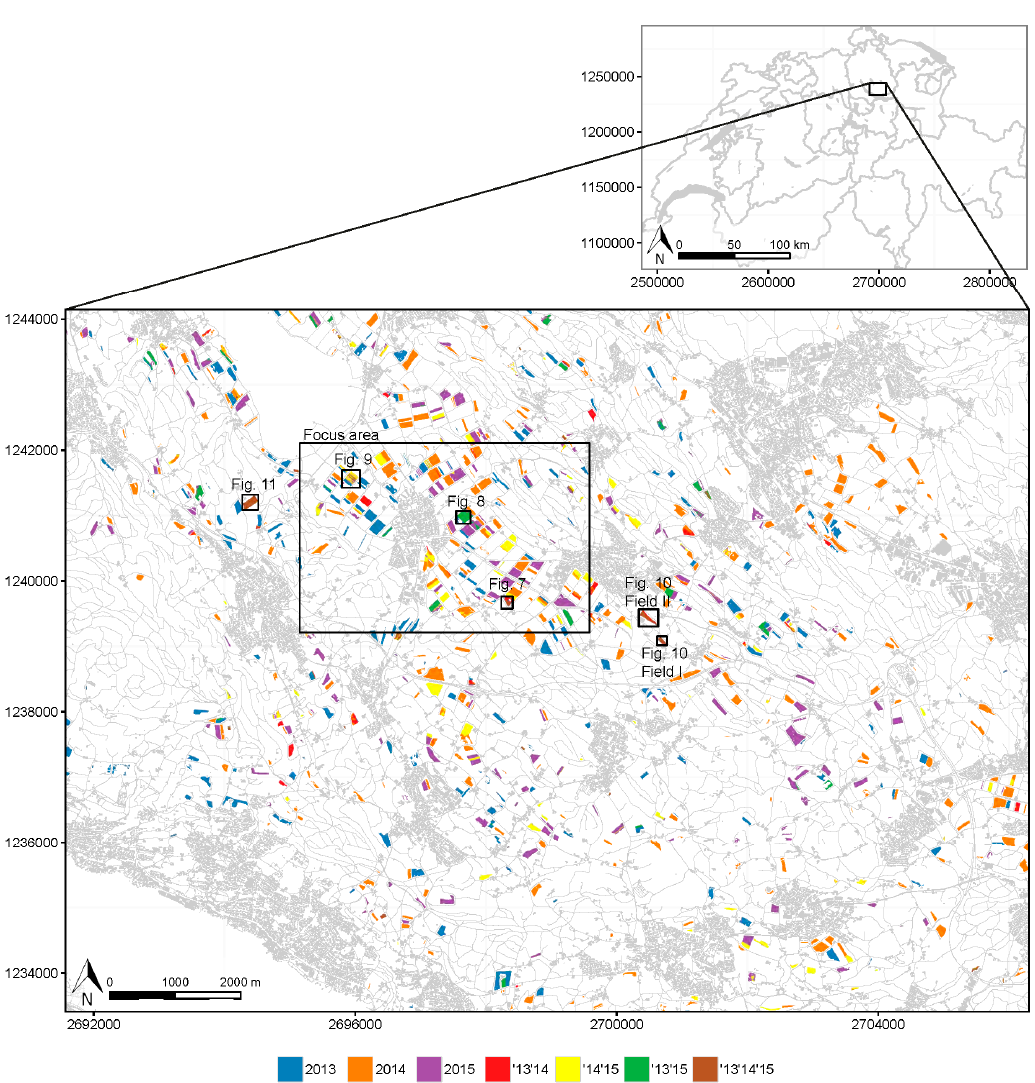
Figure 1. Study area and the distribution of the bare soil pixels, the colors show in which year(s) the considering bare soil pixel was present. The black rectangles show the locations of the focus area (used in most of the following figures) and the locations of the individual fields in Figures 7–10. The area contains a valley with a small glacial lake (Greifensee) and two ridges in the northeast and southwest, both are northwest to southeast oriented. The elevation of the area ranges from ca.